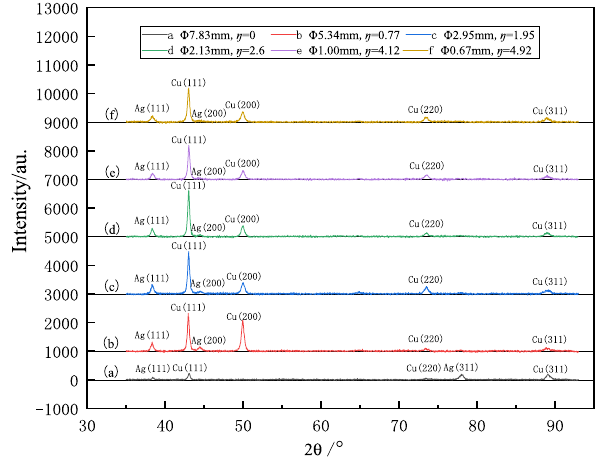
Figure 3: XRD patterns of as - cast rod and as - drawn wire with dif - ferent diameters during multi - pass continuous drawing ( a – as - cast; b – f – as - drawn ) .